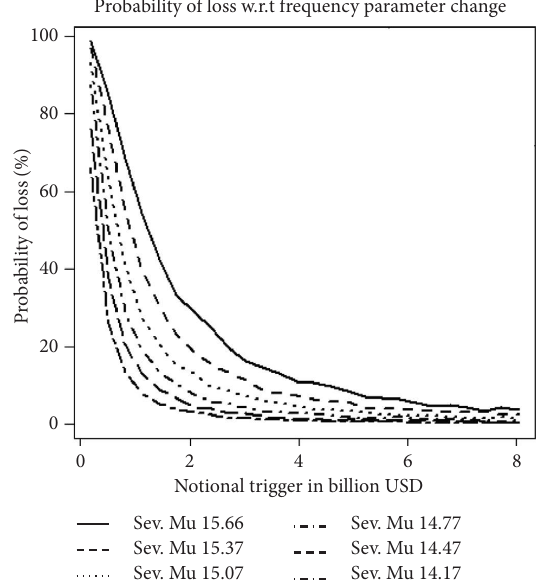
Figure 31: Cyber bond probability of loss for 3years for μ in the interval μ ± μ ·